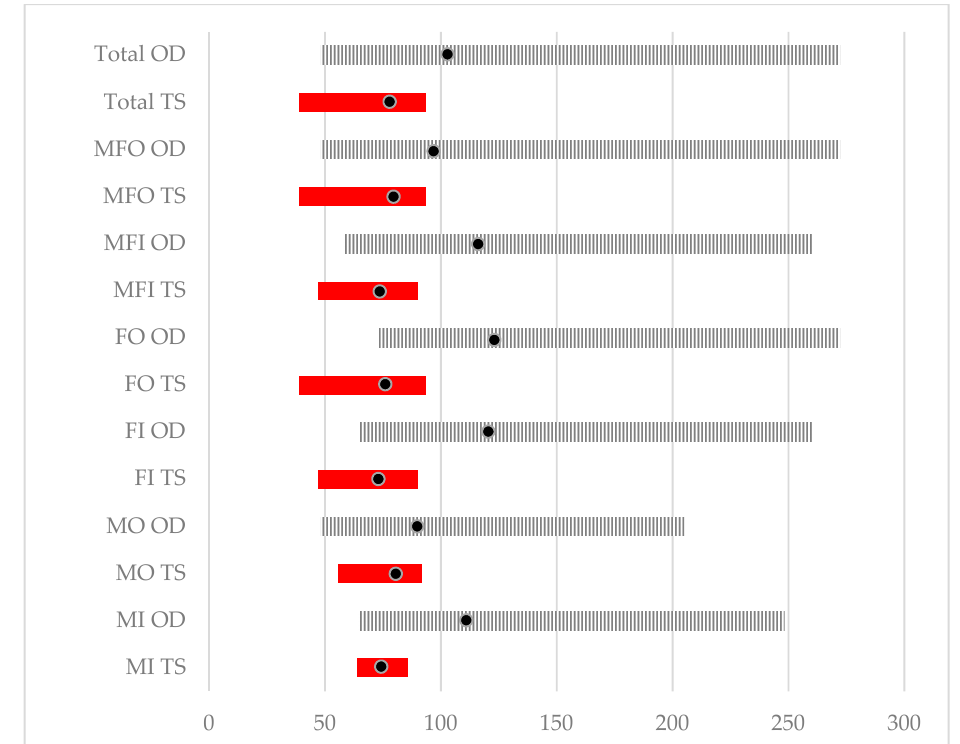
Figure 2. Competition trial results summary: Competition level; Trial score and Observed trial duration. Competition trial scores range and observed trial duration (seconds) range coded divided by sex of dogs and competition level. TS—Trial score range; OD—Observed trial duration range; MI— Improver (n = 7); MO—Male Open (n = 24); FI—Female Improver (n = 7); FO—Female Open (n = 6); MFI—Male and Female Improver (combined; n = 14); MFO—Male and Female Open (combined; n = 32); Circles within ranges indicates the mean value. Competition trial scores range from a perfect score of 100 to 0. Three dogs competed in both Improver and Open competition levels (male n = 2; female n = 1).